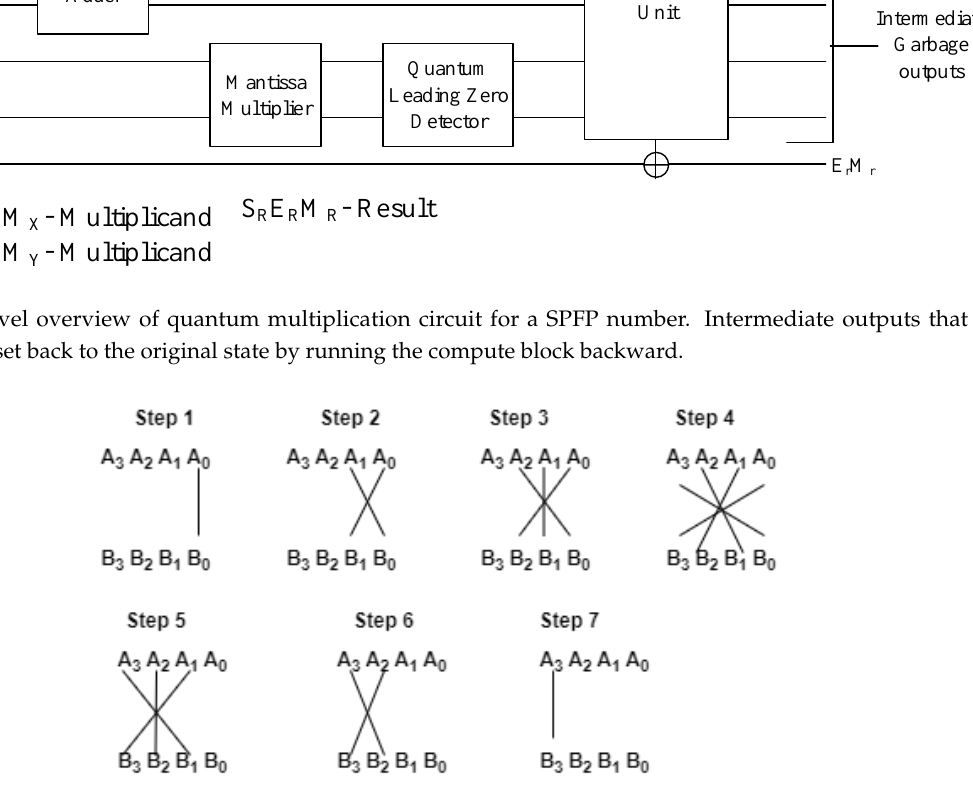
Figure 18. Line diagram structure of 4 × 4 Vedic